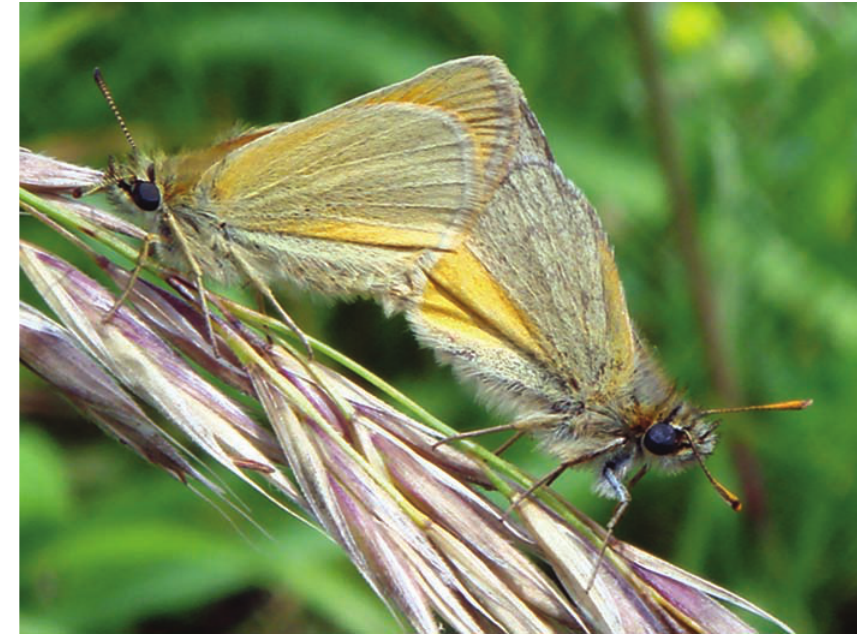
Figure 8 A pair of Small Skippers mating on the western hedgerow margin at Quarry